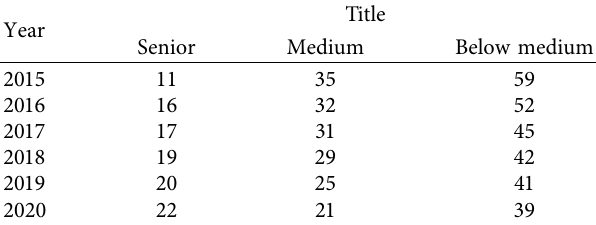
Figure 7: Prediction errors of different models. Table 1: Labor cost of libraries in